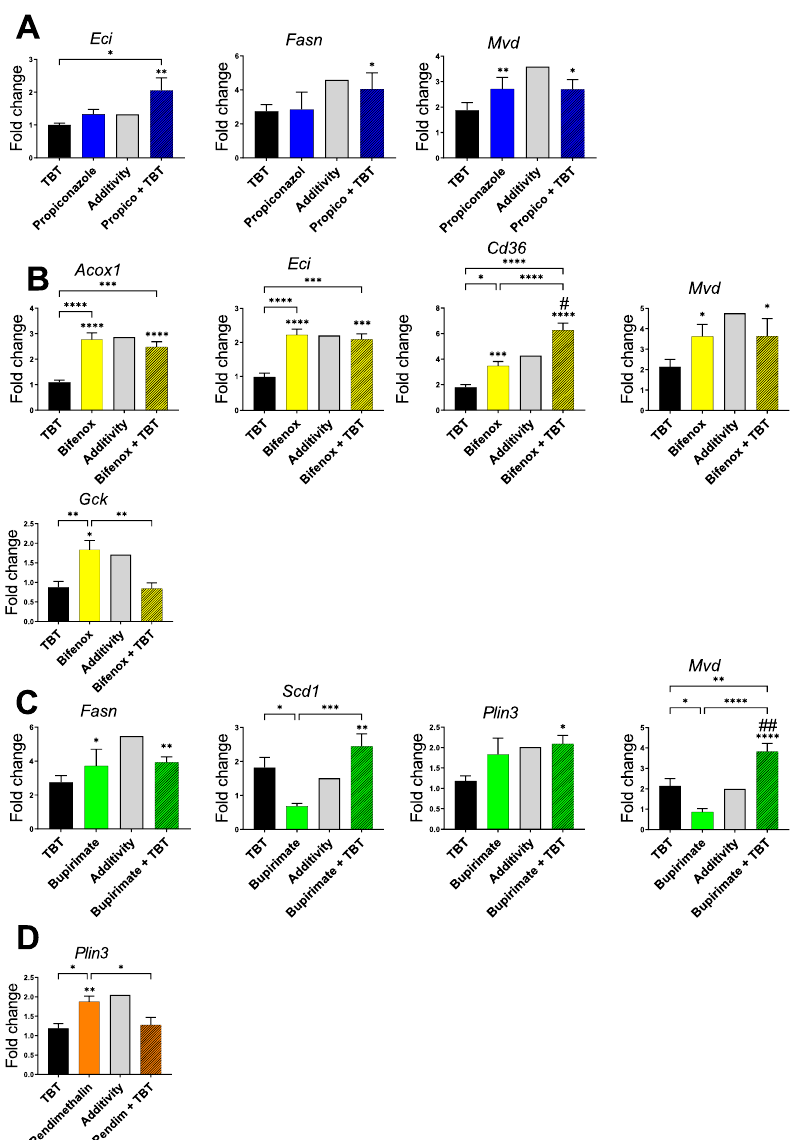
Figure 4. Gene expression levels of key metabolic pathway genes in the livers of mice according to RT-qPCR. Key genes involved lipogenesis ( Fasn and Scd-1 ), lipid droplet formation ( Plin3 ), beta- oxidation ( Acox1 and Eci ), cholesterol biosynthesis ( Mvd ), fatty acid and cholesterol transport ( CD36 ), and carbohydrate metabolism ( Gck ), deregulated by exposure to propiconazole ( A ), bifenox ( B ), bupirimate ( C ), and pendimethalin ( D ). The graph shows the results of the fold changes of the DMSO group. Data are presented as mean ± standard error. * p < 0.05, ** p < 0.01, *** p < 0.001, **** p < 0.0001. p -values represent significant differences between pesticide-treated mice and DMSO- treated mice according to one-way ANOVA test followed by Tukey’s multiple comparisons test. # p < 0.05, ## p < 0.01 represents significant difference between the observed effect of the combination of pesticide with TBT and the calculated response additivity of this combination according to a one- sample t-test.